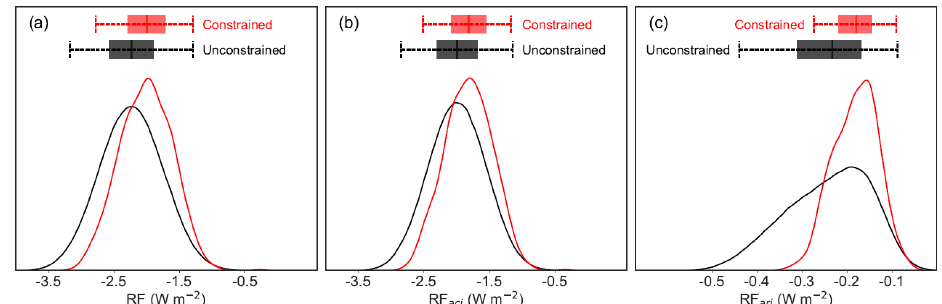
Figure 6. Probability distributions of (a) RF, (b) RF aci , and (c) RF ari from the unconstrained (black line) and constrained (red line) samples of model variants. The constrained sample includes model variants that agree with our ACE-SPACE measurement constraint and the Johnson et al. (2020) constraint. Plotting features are identical to Fig.